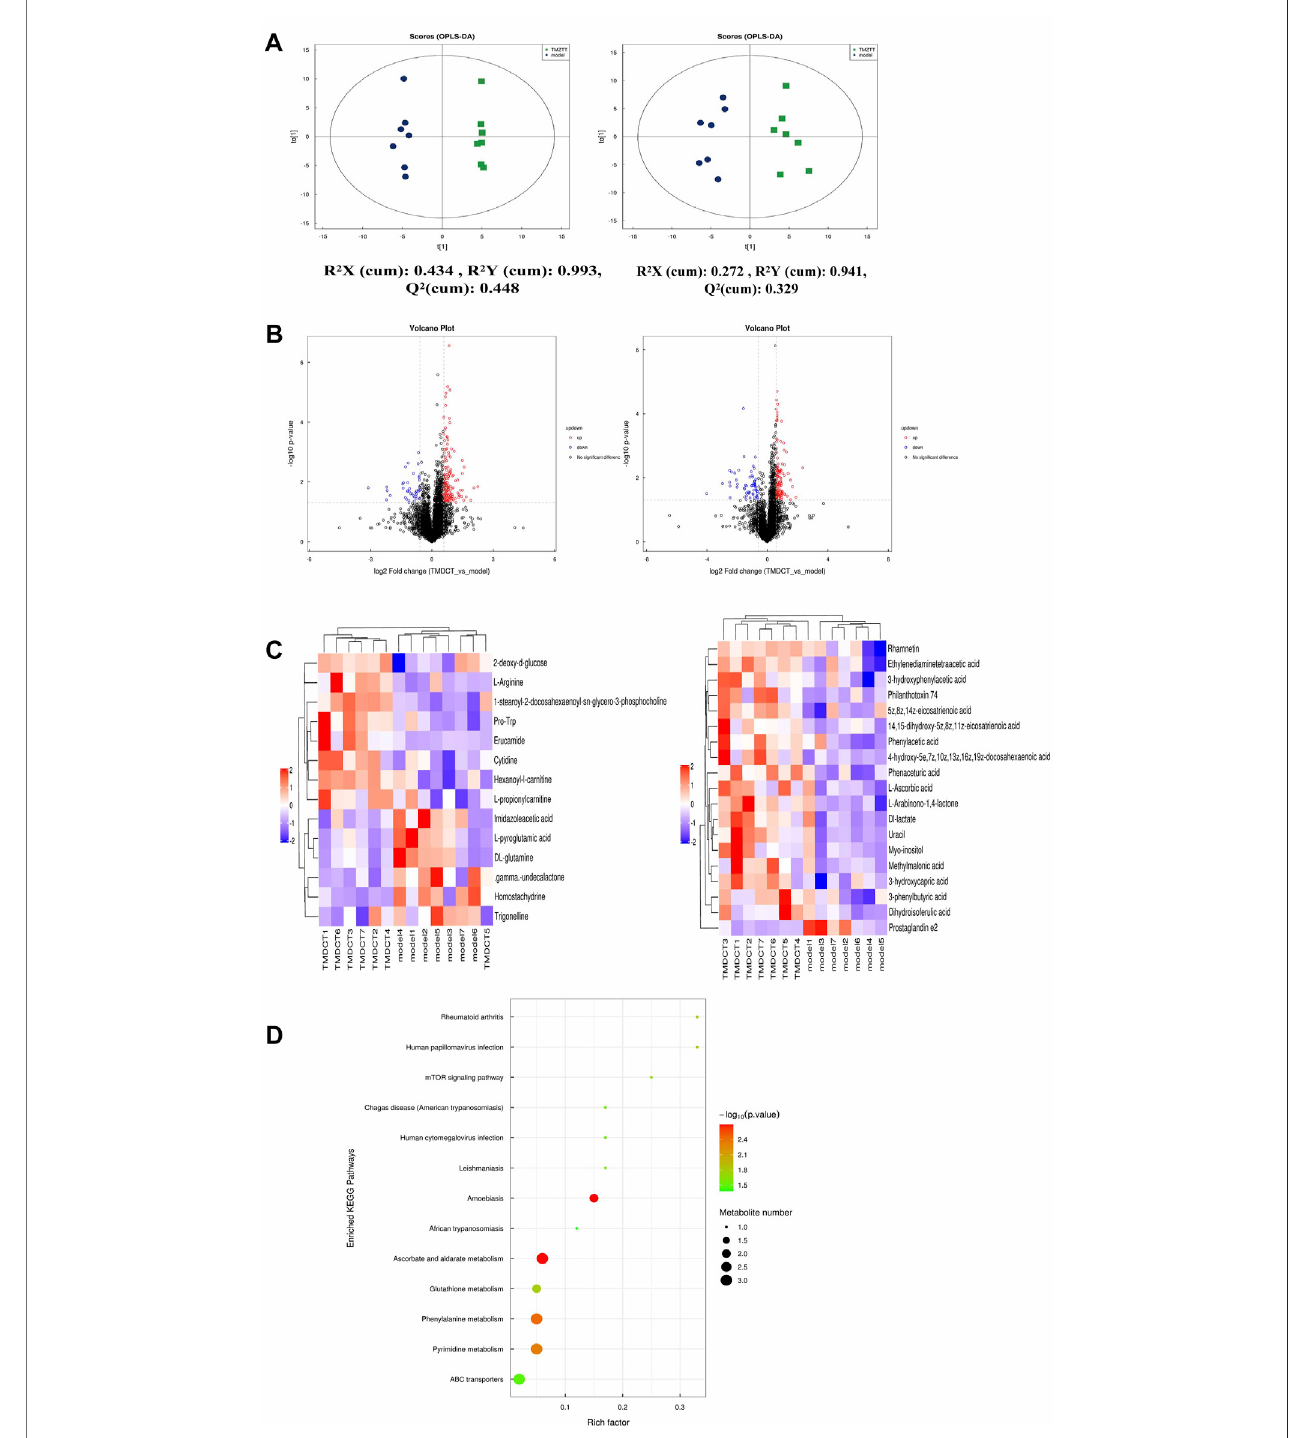
FIGURE 3 | Untarget plasma metabolism detection. (A) OPLS-DA analysis of LC/MS data in positive mode (left) and negative mode (right) from TMDCT(H) vs. Model. (B) Volcano map ofdifferential metabolites in positiveand negativemode. Themetabolites withFC > 1.5, p value < 0.05 are indicated byrose red,satisfying FC < 0.67, p value < 0.05 are shown in blue. (C) Hierarchical clustering heat map in positive mode (left) and negative mode (right). (D) Enriched KEGG pathways based on signi fi cant different metabolites between TMDCT(H) group and Model group. n =7 animals per group.